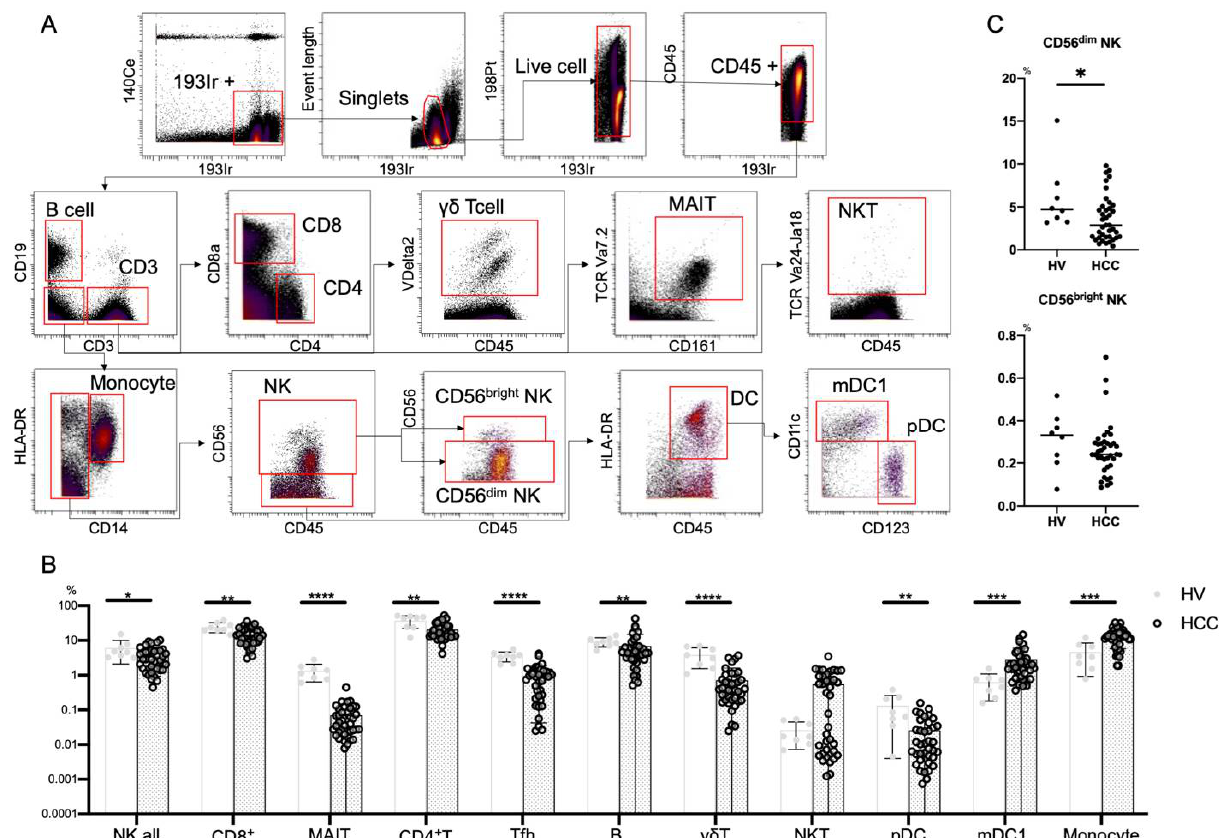
Figure 1. Frequencies of immune cells in HCC patients. ( A ) Mass cytometry gating scheme used to identify the peripheral blood immune cell subsets investigated here. Arrows indicate the gating sequence. ( B ) Summary of the frequencies of the indicated immune cell populations isolated from healthy volunteers (HVs) ( n = 8) and HCC patients ( n = 39). ( C ) Percentages of CD56 dim NK cells and CD56 bright NK cells among total peripheral blood mononuclear cells from HVs ( n = 8) and HCC patients ( n = 39). Data are presented as means ± SD ( B , C ). * p < 0.05; ** p < 0.01; *** p < 0.001; **** p < 0.0001 by the Mann–Whitney U-test ( B , C ).